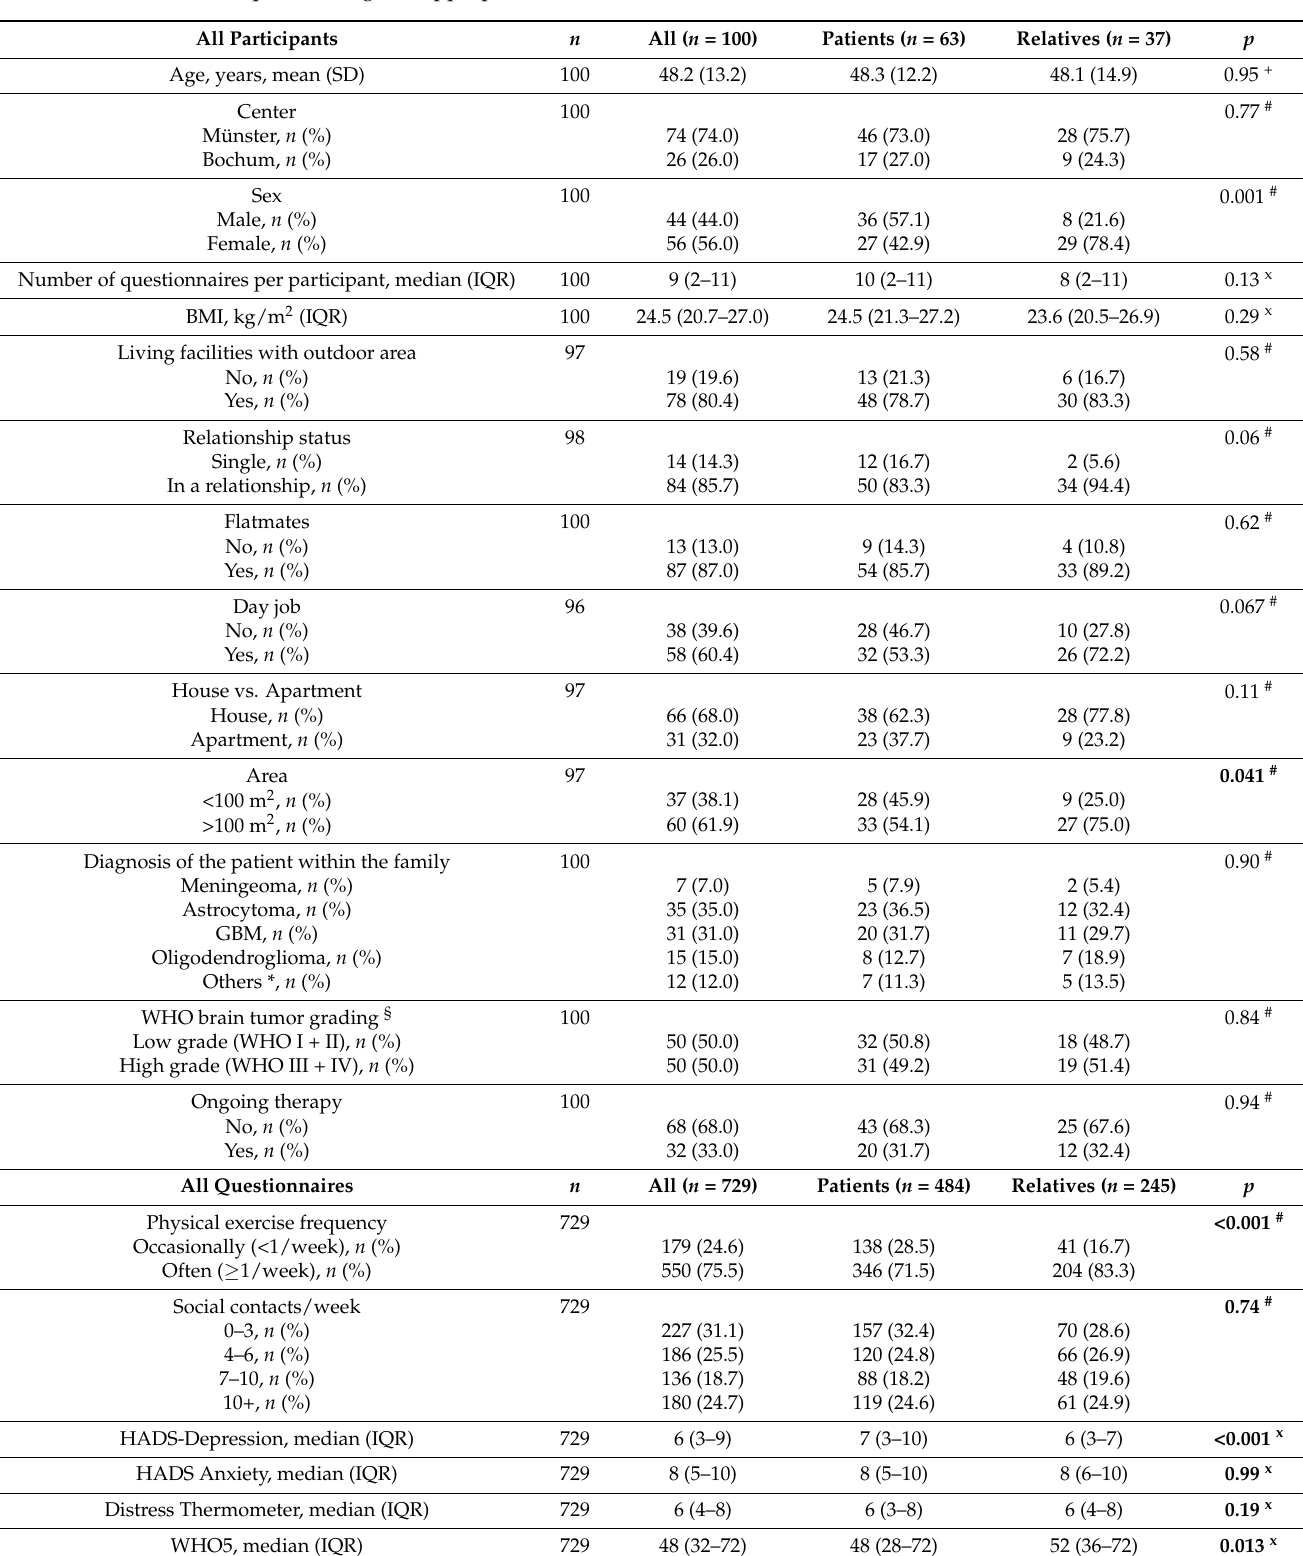
Table 1. Participant characteristics by status. Data are summarized as number and frequency, mean and standard deviation, or median and interquartile range, as